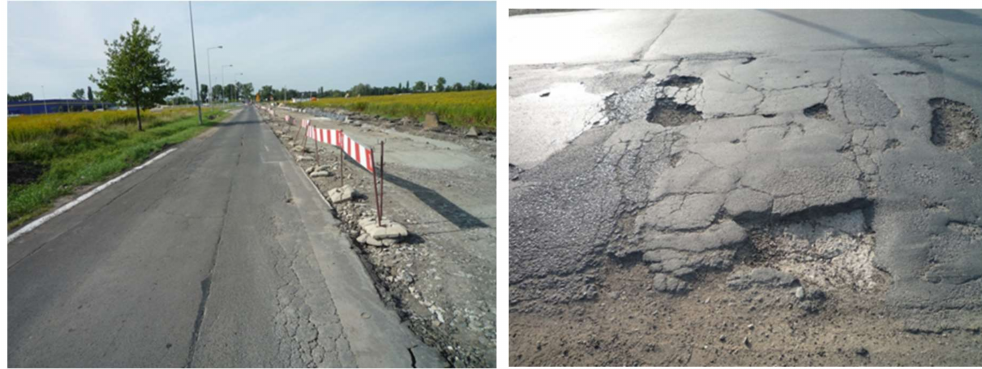
Figure 8. A section of the existing road—west lane.